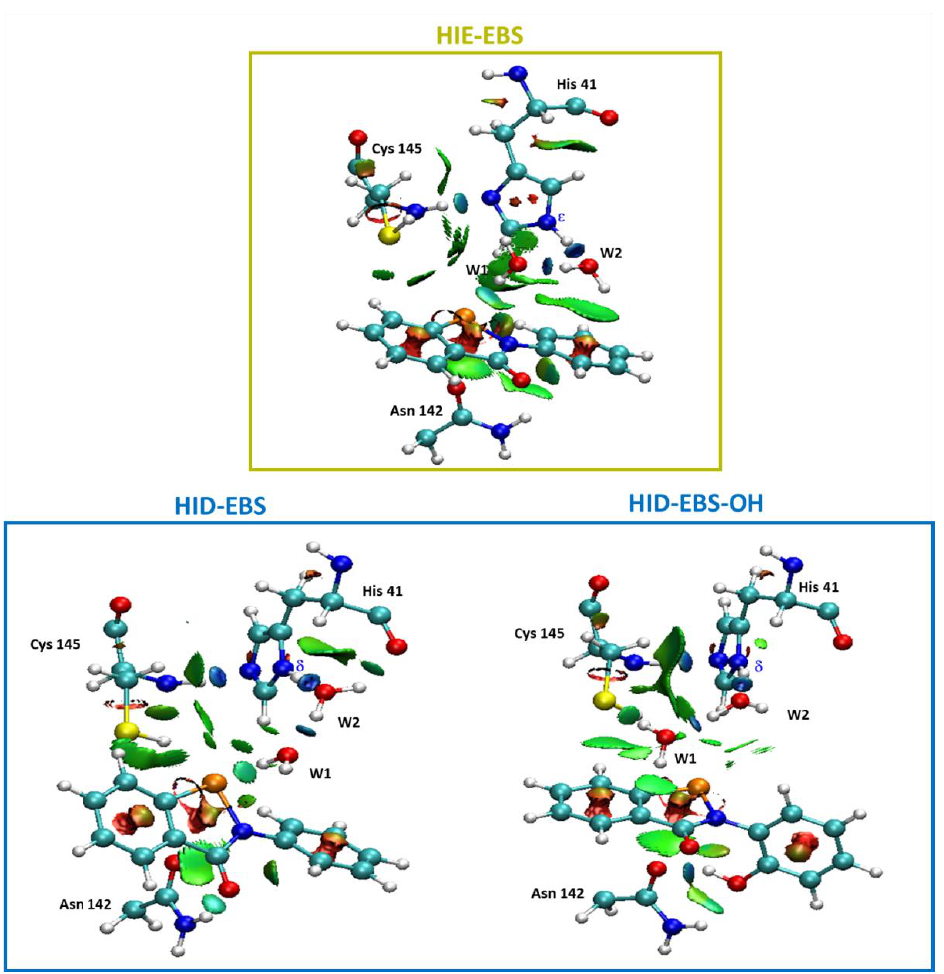
Figure 5. Noncovalent interaction plot calculated for the stationary point EI of the M pro -HIE inhibition process promoted by EBS (in yellow box). M pro -HID inhibition process promoted by EBS and EBS-OH (in blue box). For clarity, only relevant residues were kept.